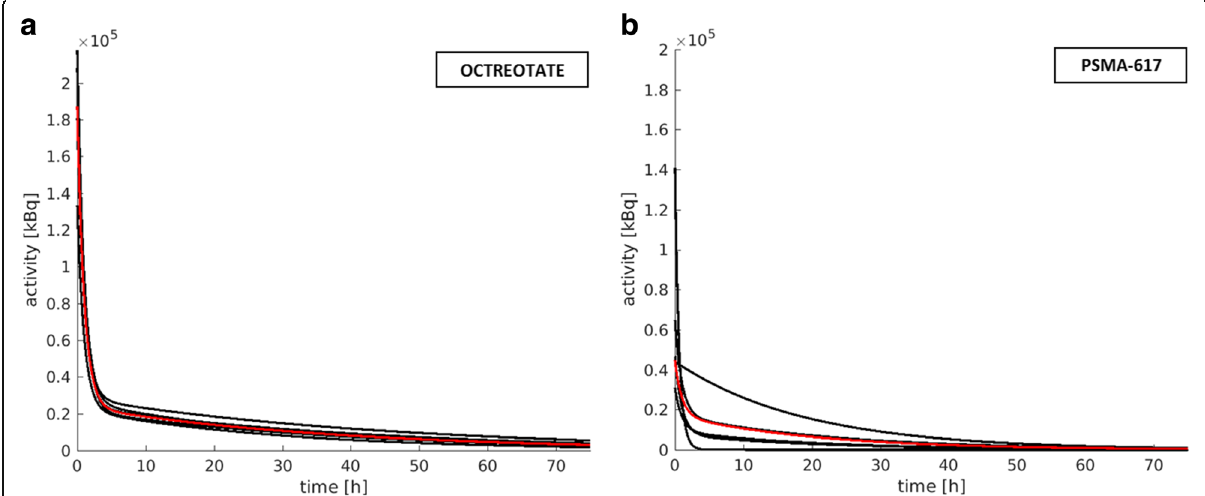
Fig. 3 Time-activity curves (TAC) for the bone marrow self-absorbed dose as determined via the blood method and for both Lu-177-Octreotate ( a ) and Lu-177-PSMA-617 therapy ( b ) (according to Eqs. (3.1) and (3.3)); the patient-specific TACs are shown in black, while the median is presented in